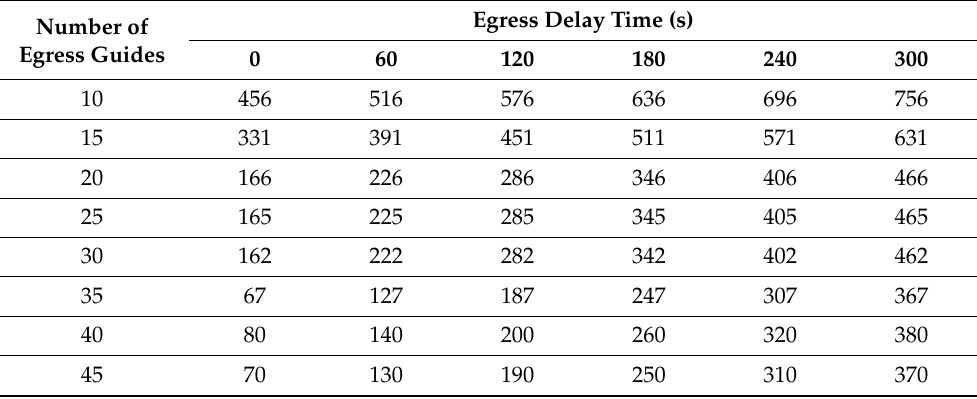
Table 5. Required safe egress time (RSET).